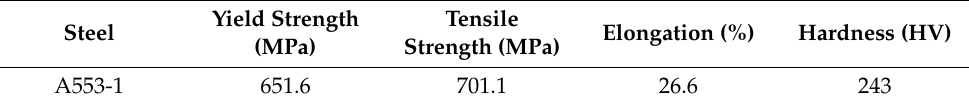
Table 2. Mechanical properties of steels